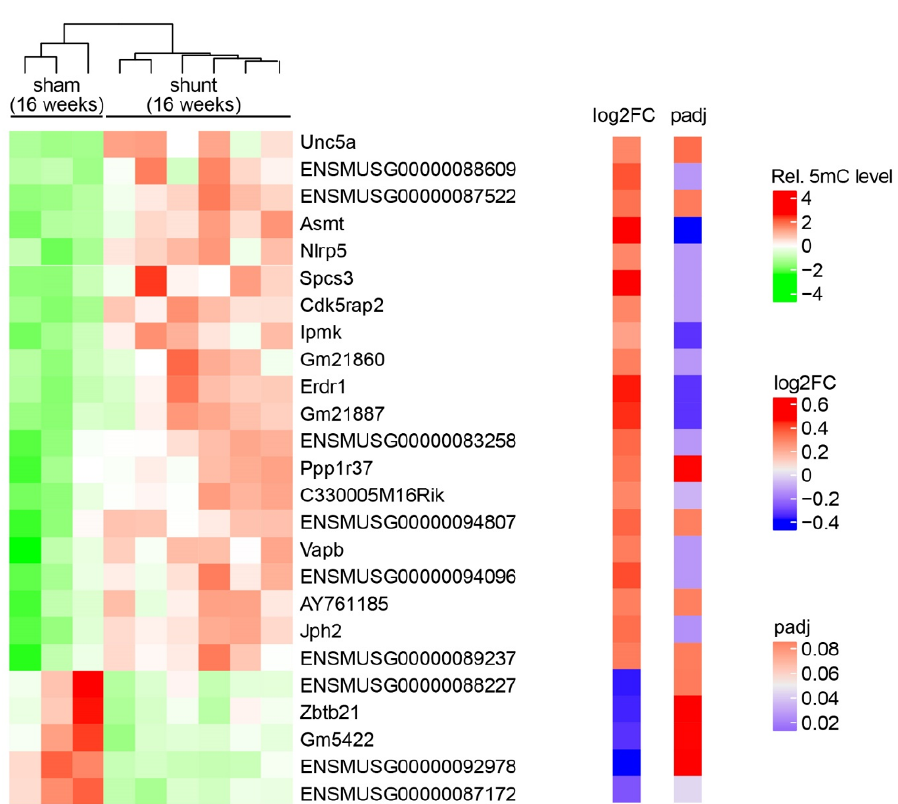
Figure 2. Differential promoter DNA methylation identified by RRBS. Heatmap showing the differen- tial DNA methylation level for the candidate genes from 3 sham and 6 shunt mouse hearts. Log2FC shows the log2 value of fold change between the mean value of the sham and the mean value of the shunt. P adj shows the adjusted p -value between the sham and shunt hearts .